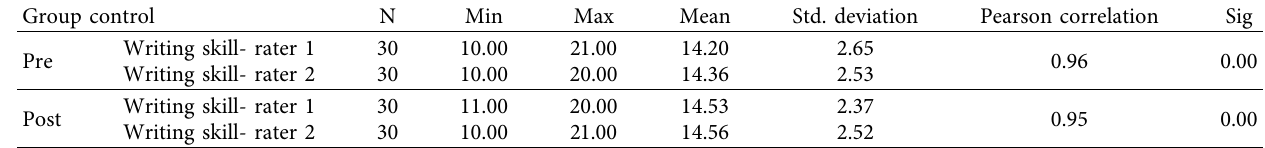
Table 12: Interrater reliability between the two raters in advanced groups (pretest and posttest). Group control N Writing skill- rater 1 Pre